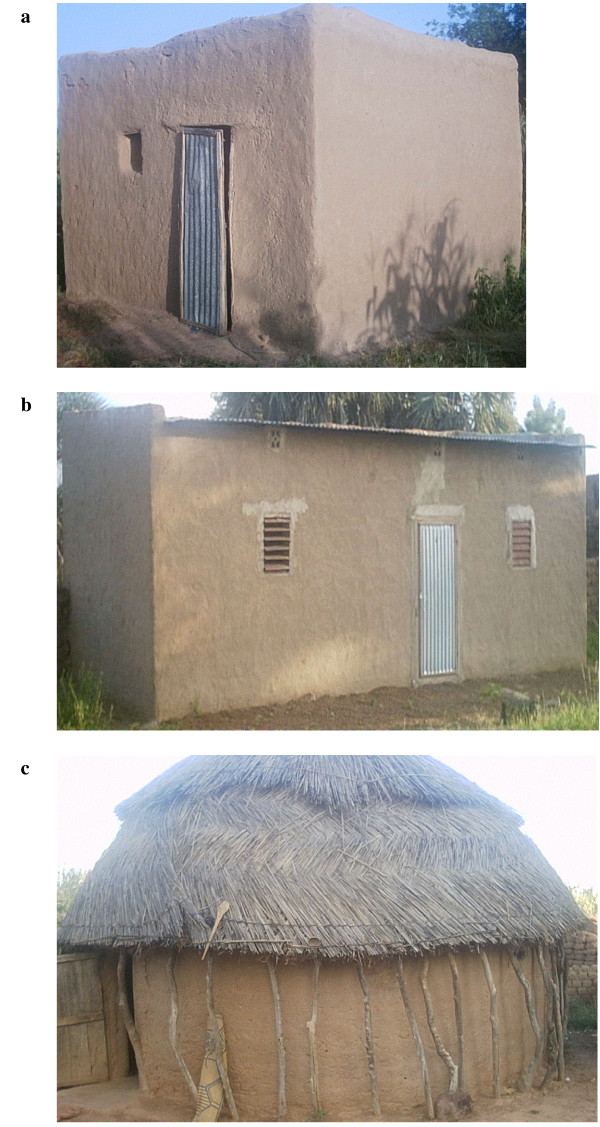
Typical housing in study region; A) mud blocks with mud roof; B) mud blocks with iron sheet roof; C) mud blocks with grass roof.